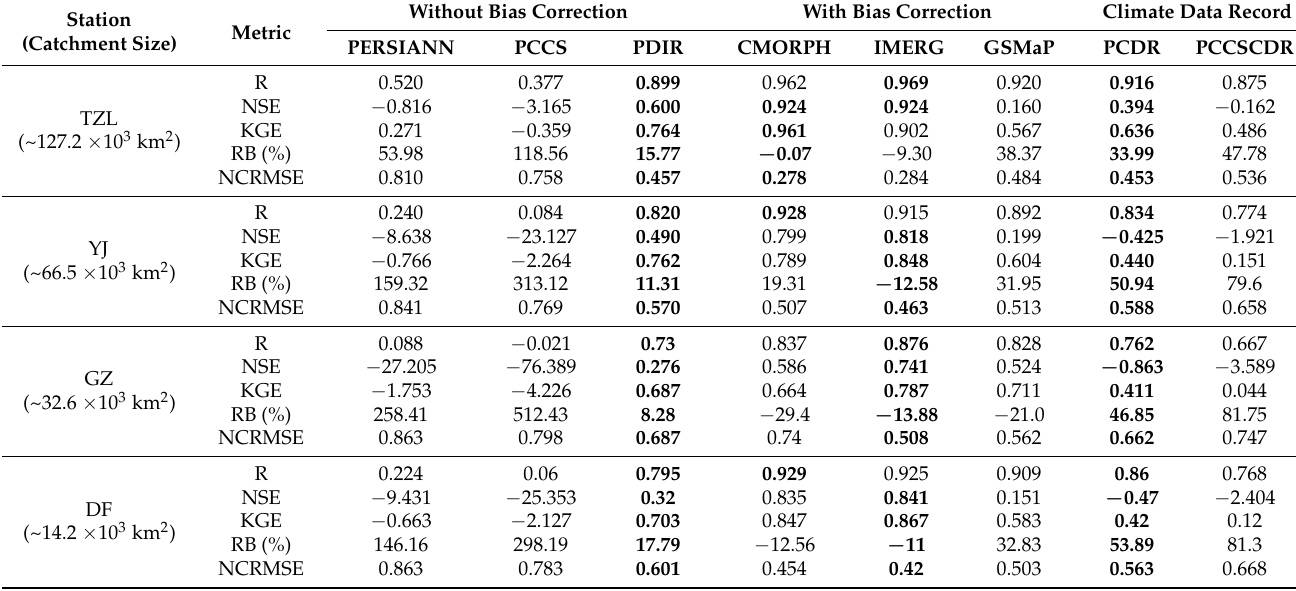
Table 3. Hydrological evaluation of eight SPEs at four hydrological stations of the YLJ basin. Pearson correlation coefficient (R); Nash–Sutcliffe efficiency (NSE); Kling–Gupta efficiency (KGE); Relative bias (RB); Normalized centered root mean square error